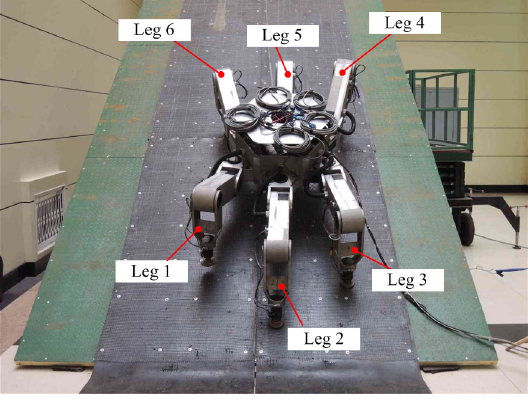
Figure 25. Climbing maximum slope experiments of robot under crab ‐ type quadrangular gait.